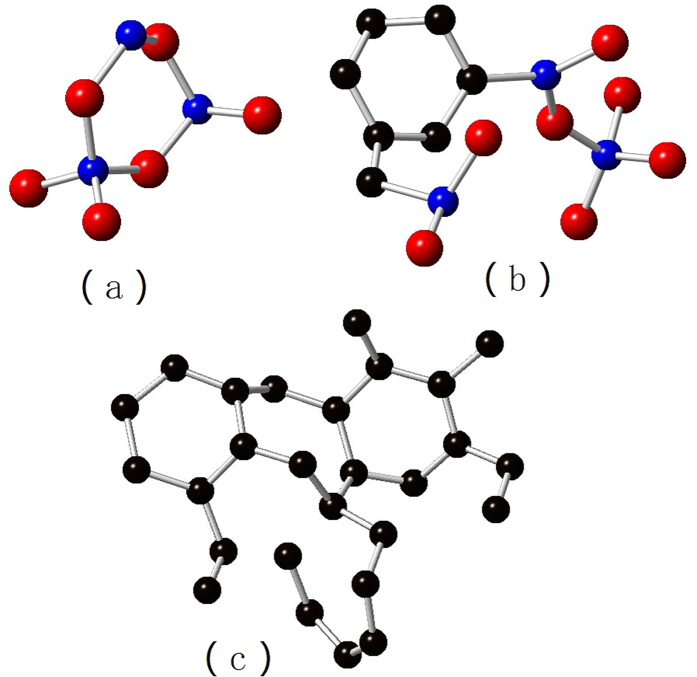
Typical molecular structure of the amorphous SiCxO6/5 structures.